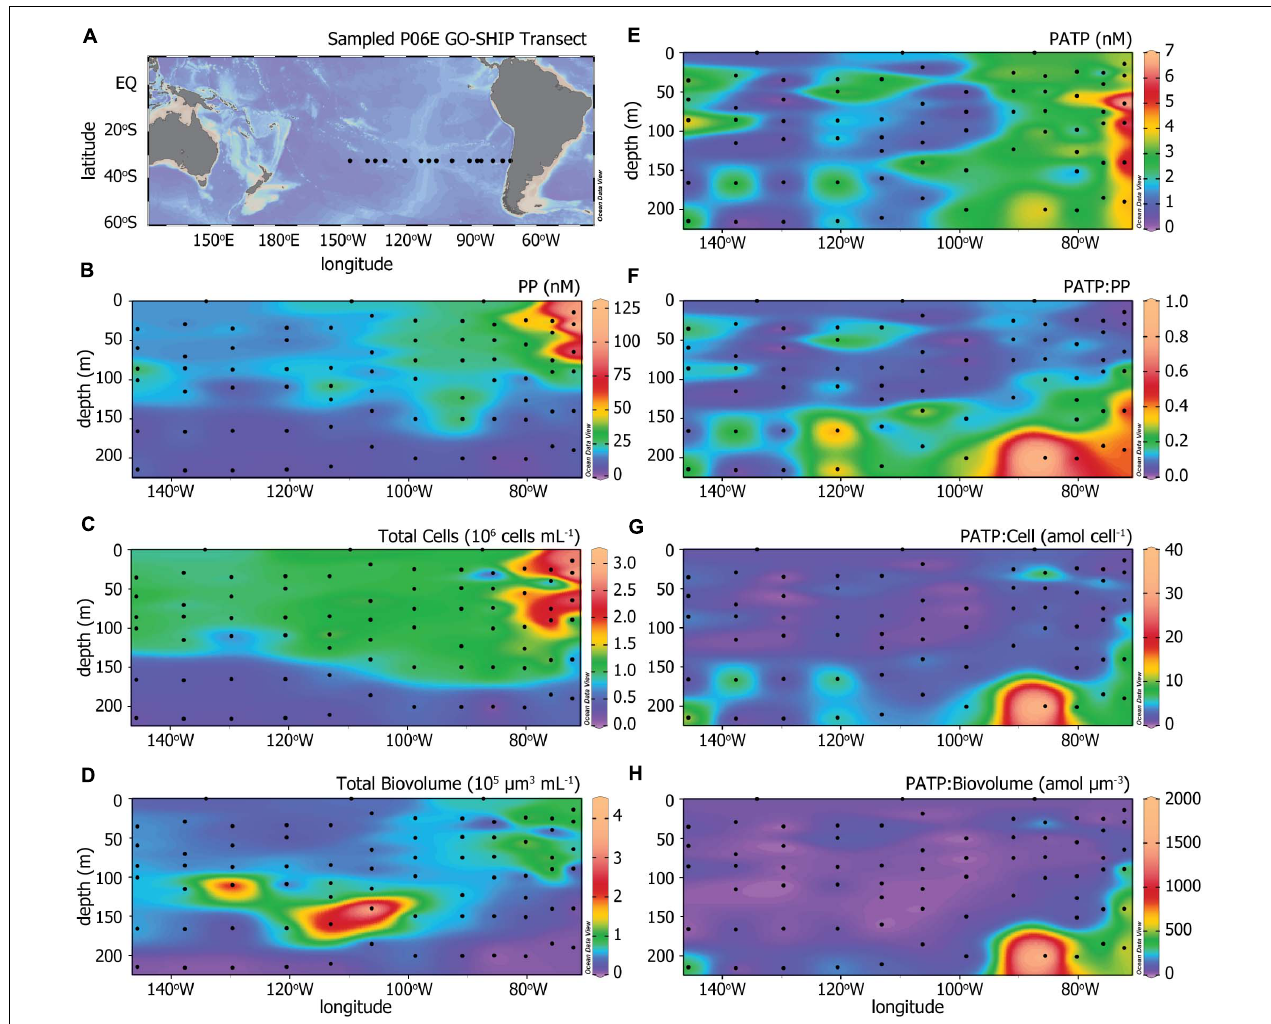
FIGURE 1 | (A) The P06E GO-SHIP Transect (2017) along 32.5 ◦ S in the Pacific Ocean. Colored heat maps of (B) particulate phosphorus (PP) concentrations, (C) total microbial cell abundances, (D) total microbial biovolume, (E) particulate adenosine triphosphate (PATP) concentrations, (F) ratios of PATP to PP (PATP:PP), (G) ratios of PATP to total microbial cell abundances (PATP:Cell), and (H) ratios of PATP to total microbial biovolume